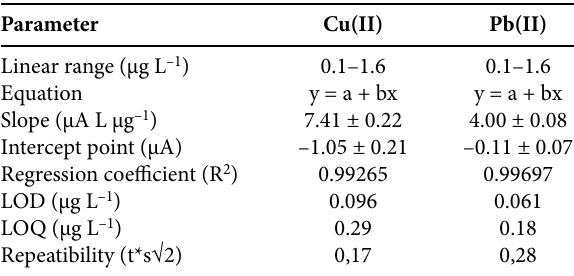
table 2. Analytical parameters for calibration curves of Cu(II) and Pb(II) obtained with DPASV method. The values of the slopes and intercepts were calculated with a confidence interval of 95%. Num- ber of points in the calibration curves was